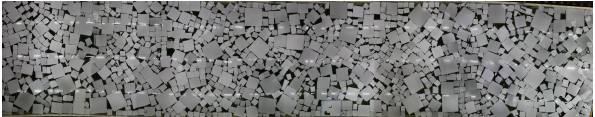
Figure 22: A stitched image of the model-ice at the HSVA ice tank in a case of deterministic ice modeling with square-shaped ice floes.